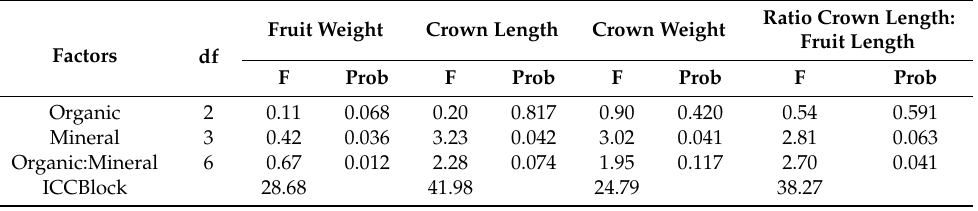
Ratio Crown Length: Fruit Length